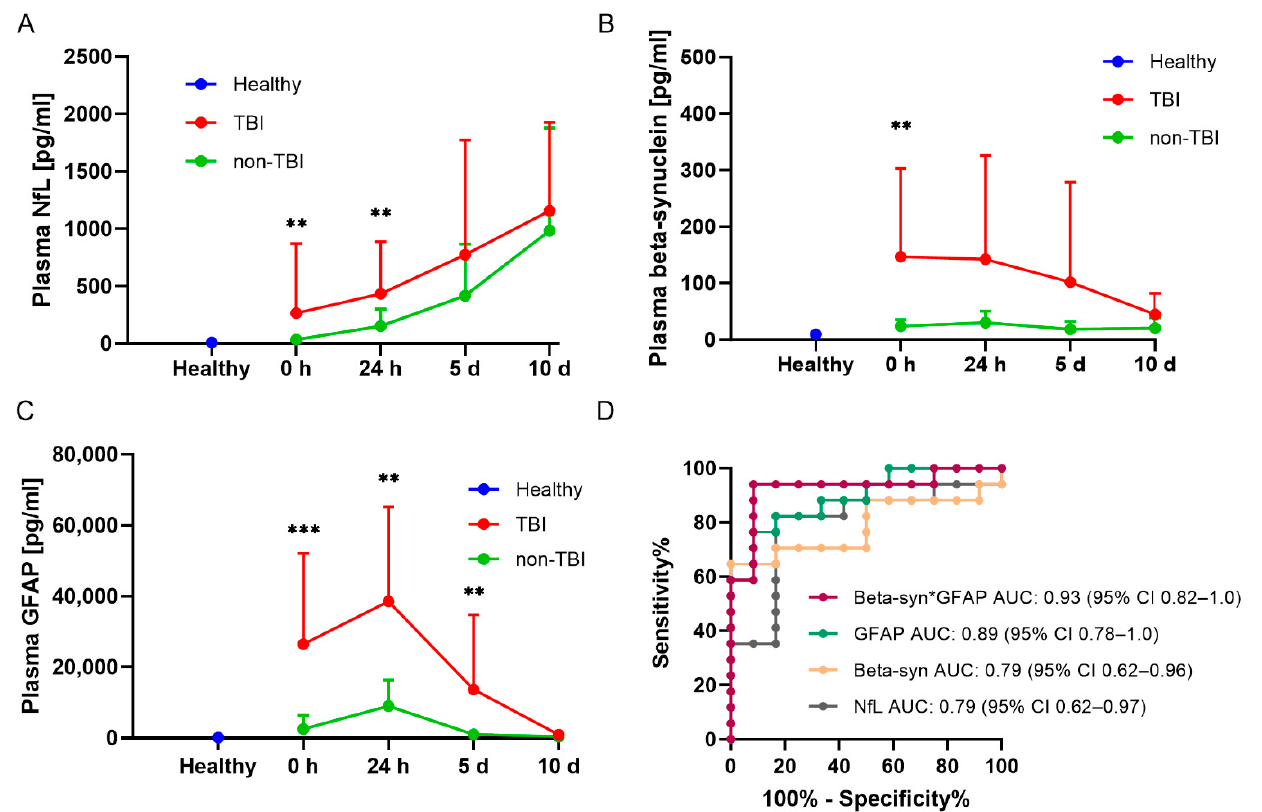
Figure 4. Marker concentrations in the time course of injury in multiple trauma with and without TBI. ( A – C ) Plasma (NfL) ( A ), beta-synuclein ( B ), and GFAP ( C ) concentrations in the time course of polytrauma with and without TBI compared to the levels of healthy volunteers. The mean plasma concentrations + SD are displayed for the individual sampling dates. Differences in marker levels between TBI and non-TBI at single time points were assessed with Mann–Whitney U test. *** p < 0.001, ** p < 0.01 vs. non-TBI. N(healthy) = 13; 0 h: N(TBI) = 17, n(non-TBI) = 12; 24 h: N(TBI) = 17, n(non-TBI) = 11; 5 d: N(TBI) = 14, n(non-TBI) = 10; 10 d: N(TBI) = 12, n(non-TBI) = 11. ( D ) Comparison of ROC curve analysis for the discrimination between TBI and non-TBI trauma patients for plasma NfL, beta-synuclein, GFAP, and the product of beta-synuclein and GFAP at admission (0 h) to the clinic. (For 0 h: TBI n = 17, non-TBI n = 12). AUC, area under the curve; GFAP, glial fibrillary acidic protein; NfL, neurofilament light chain; ROC; receiver operating characteristic; SEM, standard error of the mean; TBI, traumatic brain injury.